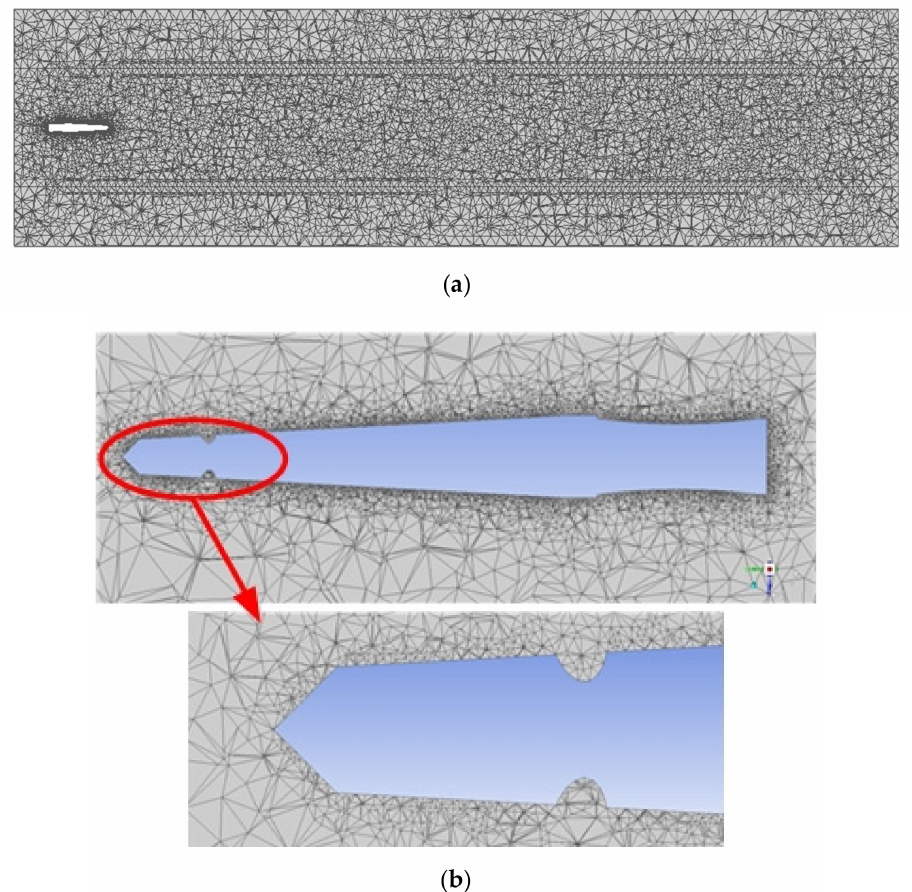
Figure 7. Computational gird of water-entry projectile: ( a ) Grid of computational domain; ( b ) Local grid of